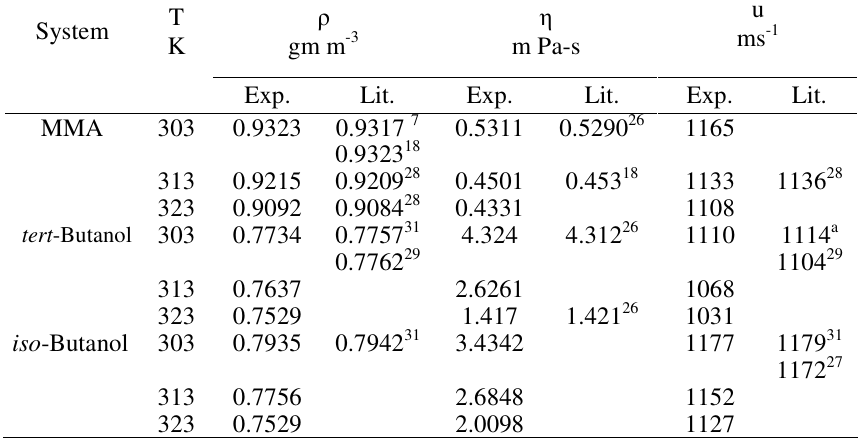
Table 1. Densities, viscosities and speeds of sound of the components of mixtures.